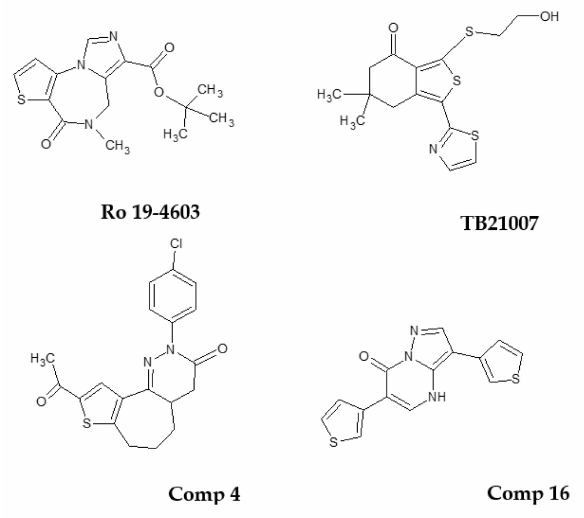
Figure 2. GABA A R ligands with a thiophene ring reported in the literature (numbering is that of the original manuscript).